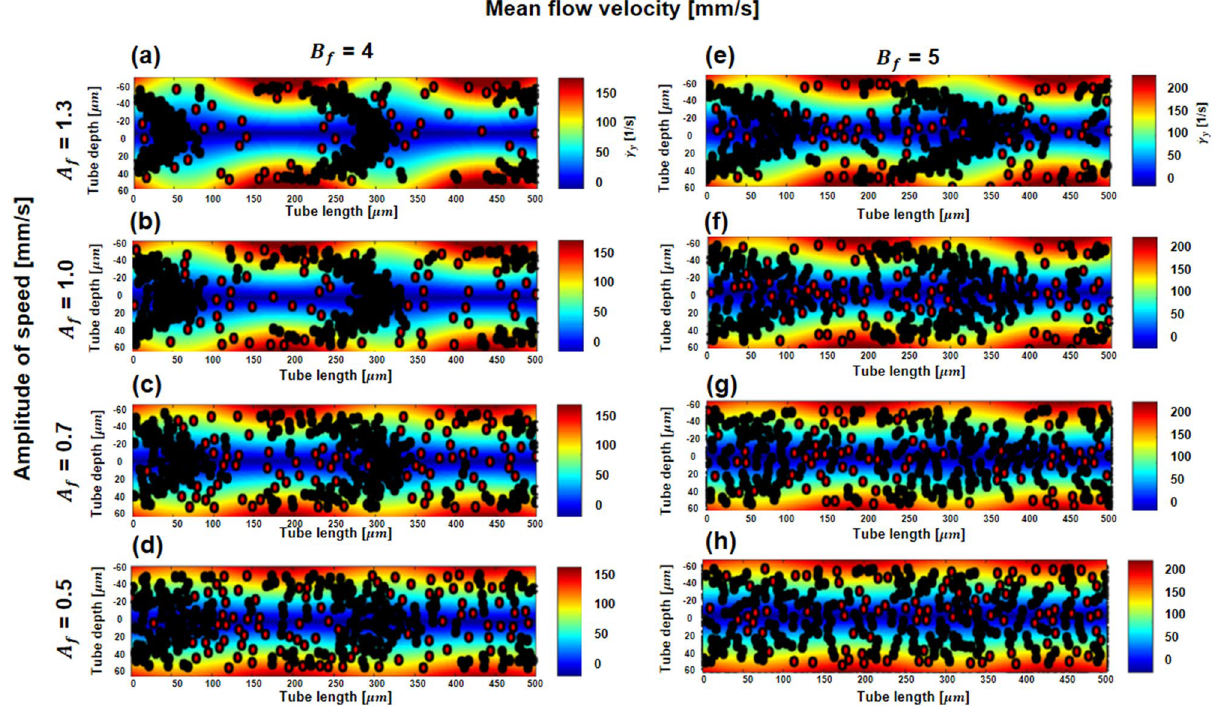
Figure 1. Snapshot of the distribution of RBCs showing formation and destruction of parabolic RBC rouleaux under sinusoidal pulsatile flow with different flow conditions at 0.96 s. Black and red particles represent aggregated and nonaggregated individual RBCs, respectively. Color bar is shear rate [1/s]. ( a–d ) RBC and its rouleaux distribution at different velocity amplitudes from 0.5 to 1.3 mm/s at a mean flow velocity of 4 mm/s. ( e – h ). The same amplitudes of flow velocity at a higher mean flow velocity of 5 mm/s. The lower the mean flow and the higher the velocity amplitude are, the stronger the local parabolic The ratio of axial and radial shear rates ( ˙ γ x / ˙ γ y ) at the central area of the tube changed spatiotemporally with the flow conditions. When this ratio increased, the influence of the axial shear rate on RBC aggregation was relatively important to form a local parabolic of rouleaux under sinusoidal pulsatile flow. The flow velocity field and shear rates are shown in Fig. 2 at a specific time (t/T = 0), with a velocity amplitude of 1 mm/s and a mean flow velocity of 4 mm/s. In this figure, the white solid lines indicate 10 divided sections of flow velocity and shear rates with the same area. The shear rate is combined with radial and axial components (Fig. 2b). The decomposed shear rate fields show the radial shear rate ( ˙ γ x ) (Fig. 2c) and the axial shear rate ( ˙ γ x ) (Fig. 2d). The radial shear rate range is approximately 0–200 s −1 , and the axial shear rate range is approximately − 25 s −1 to 25 s −1 . The shear rate near the center was mainly affected by the axial shear rate due to the low mean radial shear rate of approximately 20 s −1 , while the shear rate was generally similar to the radial shear rate except in the central area, as shown in Fig. 2b,c. RBC aggregation distributions considering the spatial variation in the shear rate fields were confirmed by increasing the amplitude of velocity from 0.5 to 1.3 mm / s with a mean flow velocity of 4 mm / s . We attempted to explain RBC aggregation and parabolic rouleaux as a function of the radial shear rate (Fig. 3a–c) and axial shear rate (Fig. 3d–f) in the ROIs. The white solid lines represent 10 ROIs of the same area and the same shear rate range. Increasing the amplitude of velocity significantly changes the spatial distribution of the radial shear rate fields (Fig. 3a–c). The distribution of RBCs did not follow the radial shear rate field. The axial shear rate fields and RBC distributions are shown in Fig. 3d–f. The distribution of RBC aggregation was obviously related to the axial shear rate. Local aggregation occurred at a specific axial shear rate, and the parabolic rouleaux shape was clearly observed with increasing axial shear rate from the minimum value. We compared the RBC distribution as a function of two components of shear rate in an ROI. The ratio of shear rates at the tube center area was changed to affect the RBC distribution with changing velocity amplitude from 0.5 to 1.3 mm/s with mean flow velocity of 4, 5, or 7 mm/s. Figure 4a–c and d–f show normalized aggre- gated RBC numbers as a function of axial mean shear rate ( ˙ γ x ) and radial mean shear rate ( ˙ γ y ), respectively. The number of aggregated RBCs was normalized by the number of randomly distributed RBCs in the ROI at the initial condition. The normalized aggregated RBC number is greater than 1 when the local hematocrit is higher than 40% in the ROI, mainly due to rouleaux formation. The maximum normalized number of RBC aggregates was approximately 2.7 at the axial shear rate of − 23 s −1 and the maximum shear rate ratio of 0.32 (A f = 1.3 mm/s, and B f = 4 mm/s) (Fig. 4a). When the maximum shear rate ratio decreased, the maximum normalized number of aggregated RBCs also decreased. The number of aggregated RBCs was also reduced significantly when the mean flow velocity increased from 4 to 7 mm/s (Fig. 4a–c), showing a minimal variation for a mean flow veloc- ity of 7 mm/s. These results explain the effects of axial shear rate on RBC aggregation in terms of the rouleaux